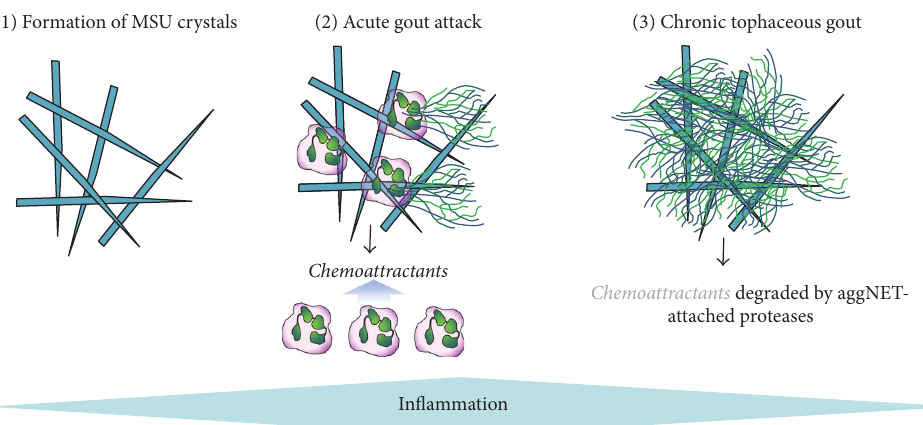
Figure 2: The proposed role of PMNs in the immunopathogenesis of gout. Phase (1) shows the deposition of needle-shaped MSU crystals. Phase (2) depicts PMNs phagocytosing crystals and releasing chemoattractants and NETs. Phase (3) shows the formation of aggregated NETs (aggNET) that provide the structural basis of gouty tophi and contain high concentration of PMN proteases degrading PMN